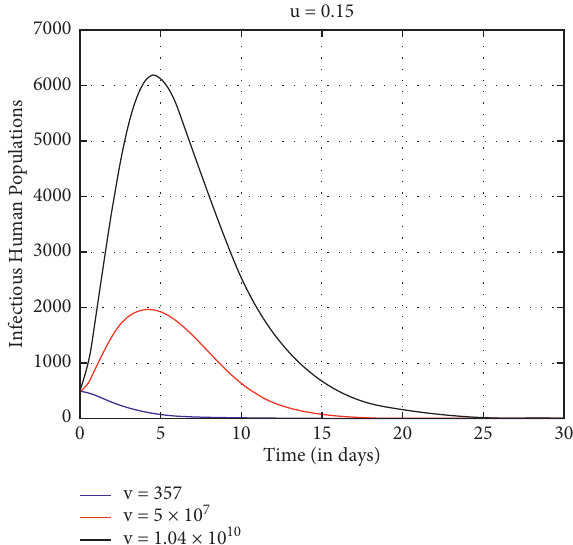
Figure 21: Infectious human population with different virus loads when u � 0 .